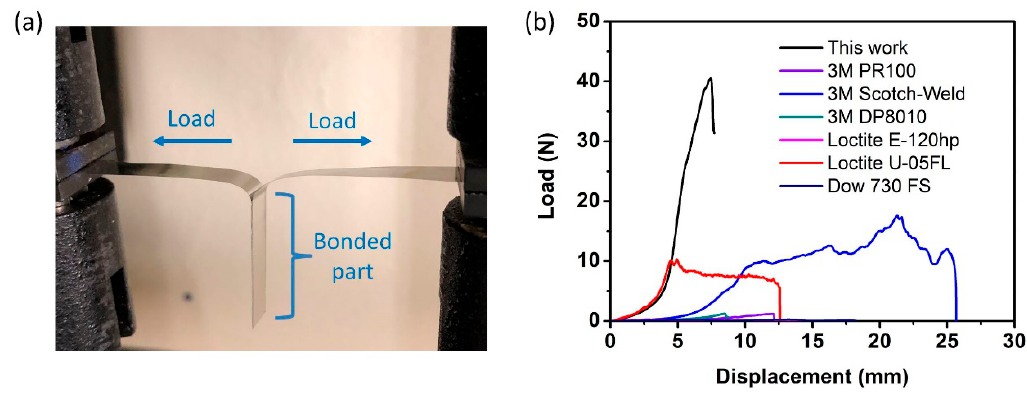
Figure 3. Peel strength of adhesives. ( a ) T-peel test setup and ( b ) the load-displacement curves of the T-peel tests for the different adhesives on steel.